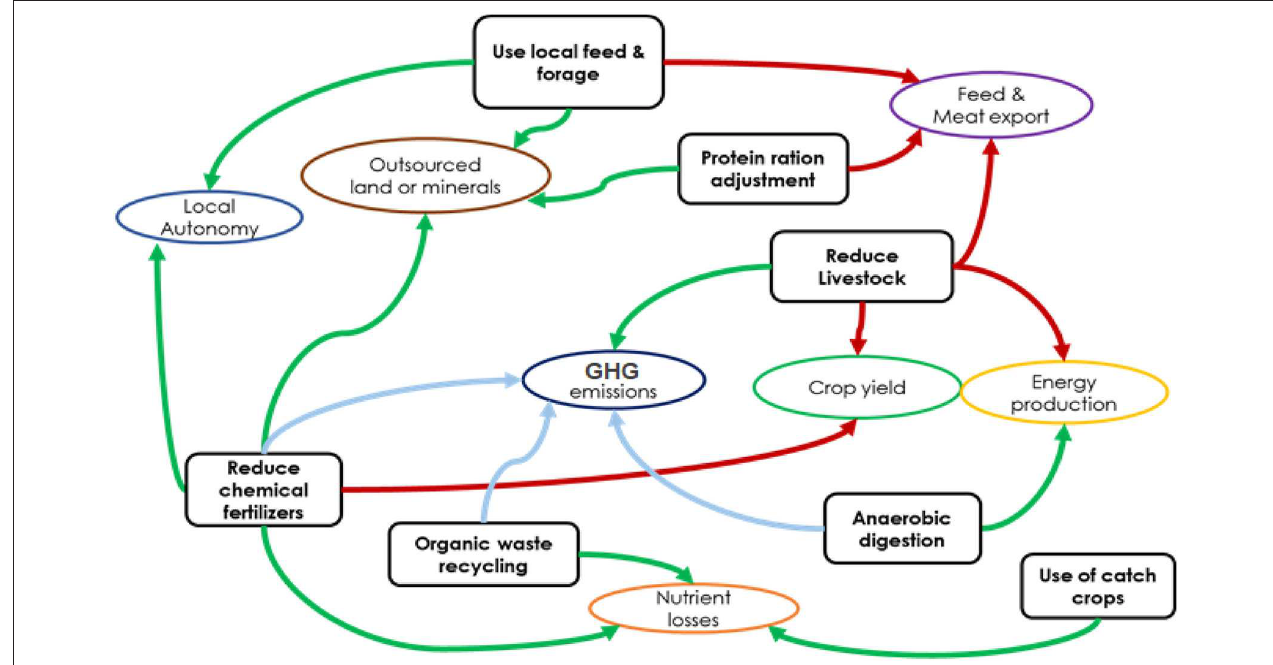
FIGURE 2 | Hypothesized effects of the leverage factors (boxes) on key indicators of the system performance (circles). Arrows represent interactions between leverage factors and system performances. Green arrows stand for positive effects, red arrows for negative effects and light blue for unknown